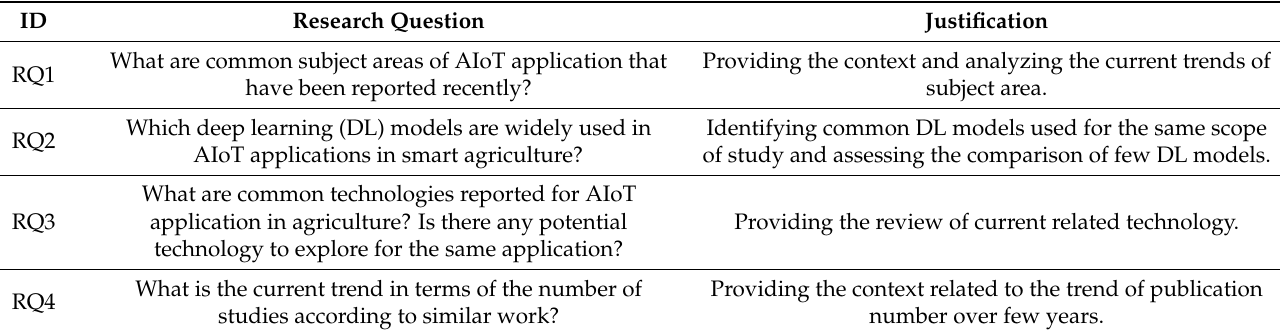
Table 1. Research question and justification.